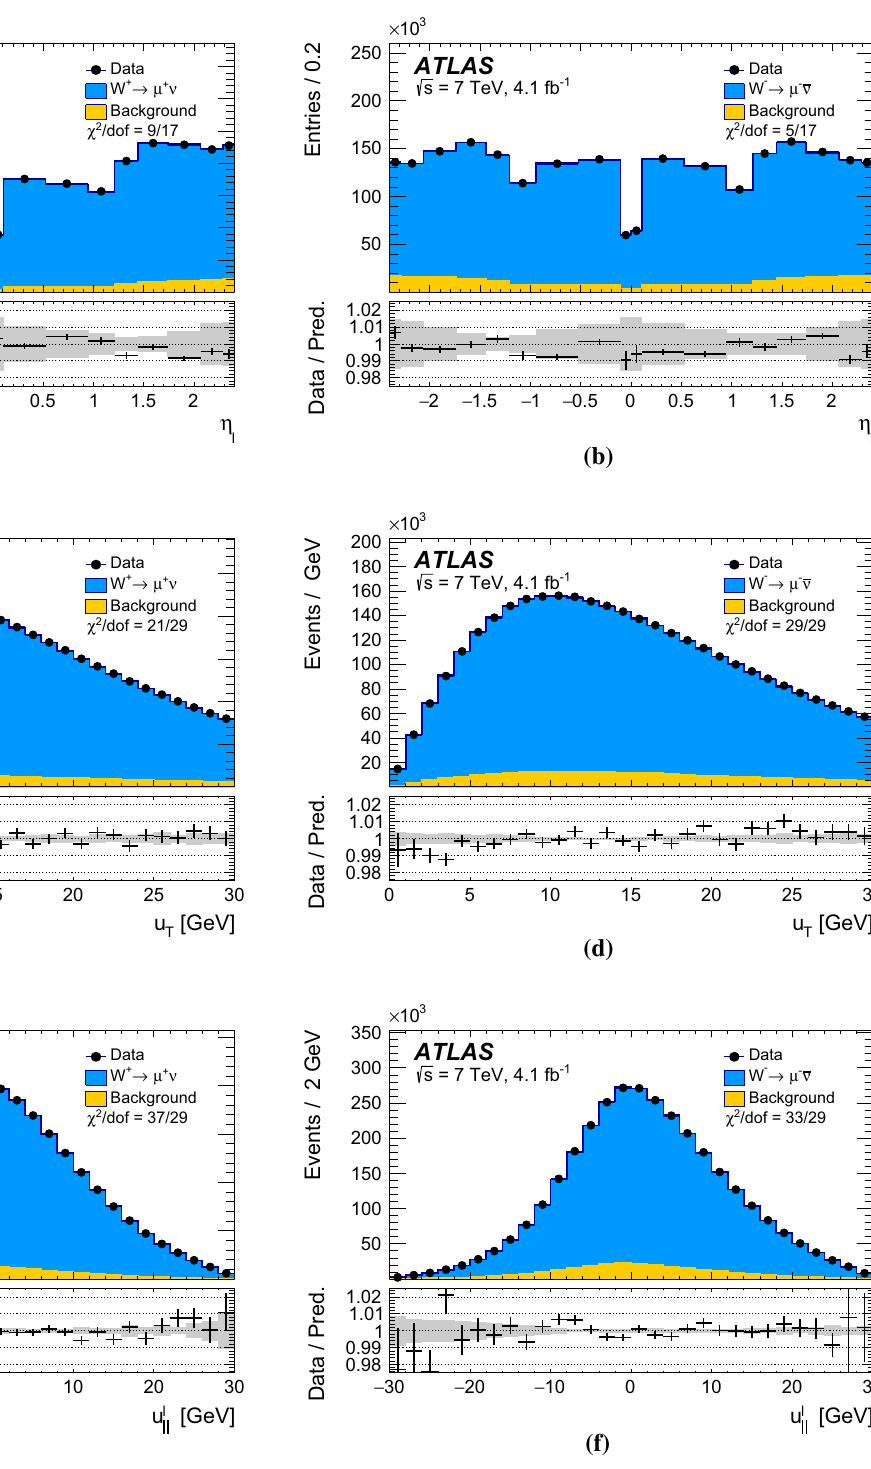
Fig. 20 The a , b η (cid:7) , (c,d) u T , and e , f u (cid:7) (cid:5) distributions for a , c , e W + events and b , d , f W − events in the muon decay channel. The data are compared to the simulation including signal and background con- tributions. Detector calibration and physics-modelling corrections are applied to the simulated events. The lower panels show the data-to-